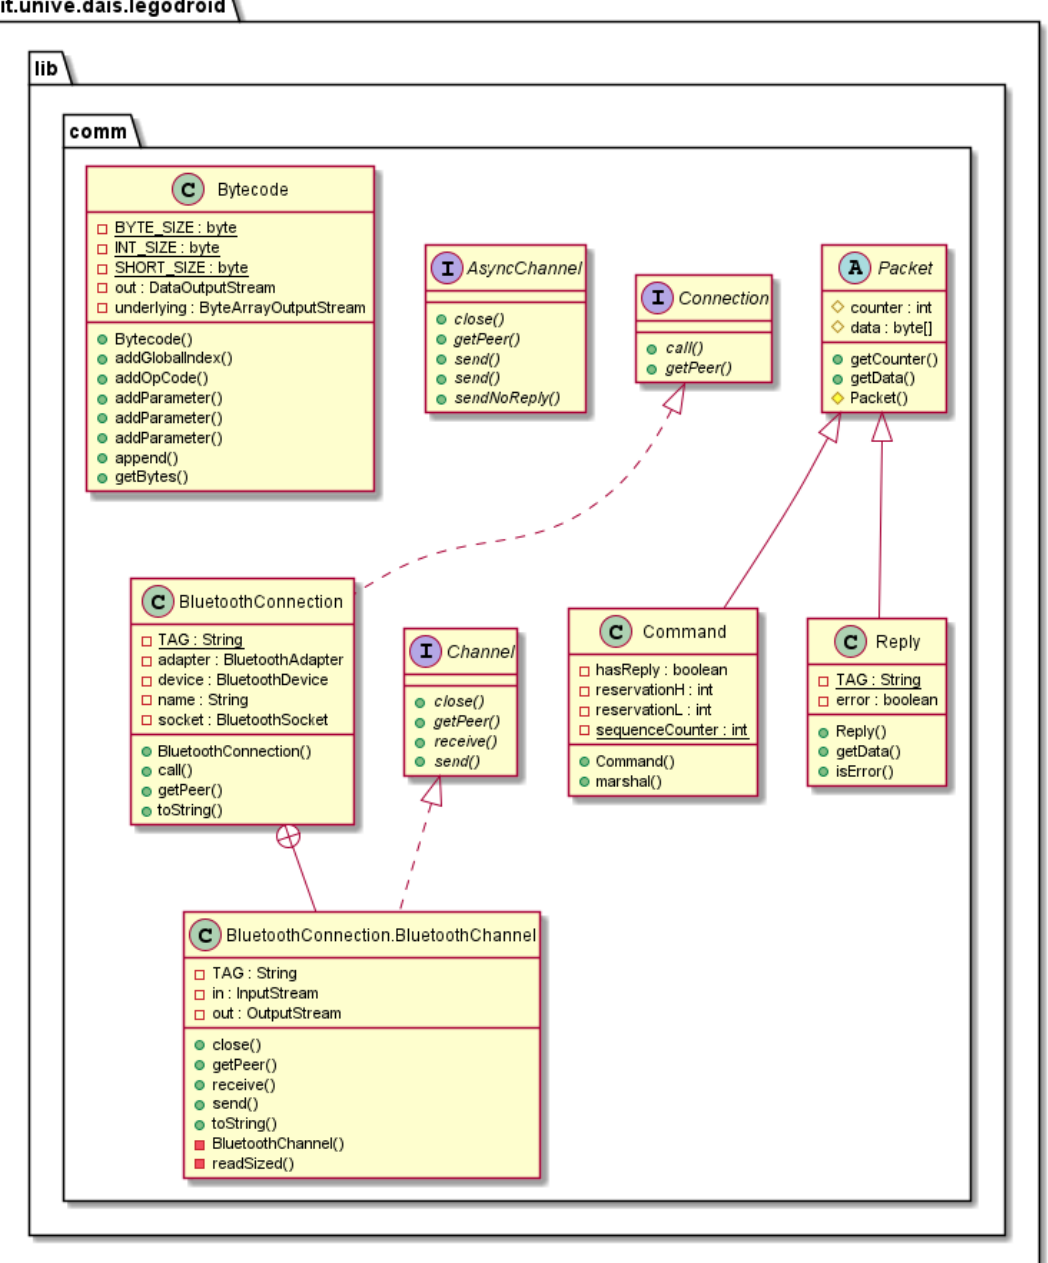
Figure 3. UML Class Diagram of package legodroid.lib.comm